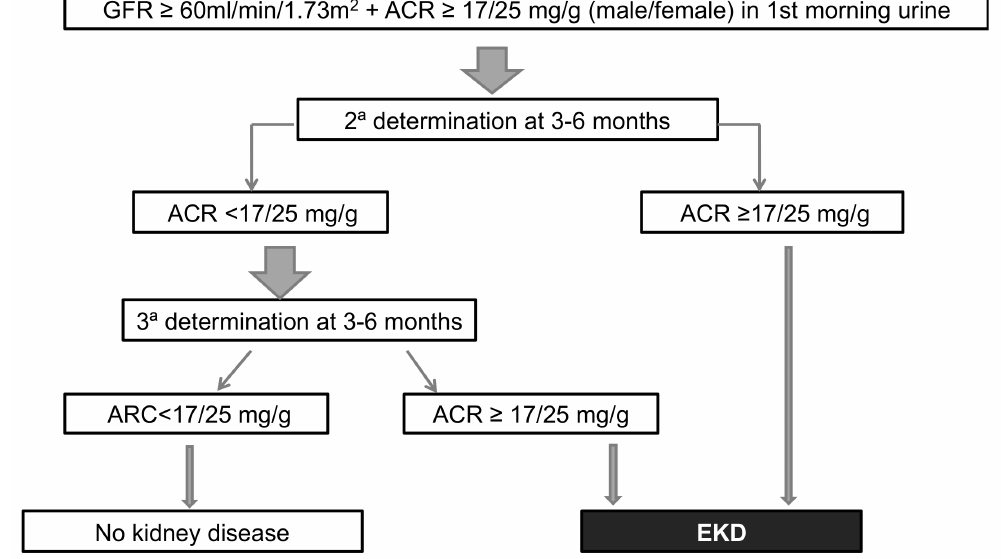
Figure 1. Diagnosis of early kidney disease